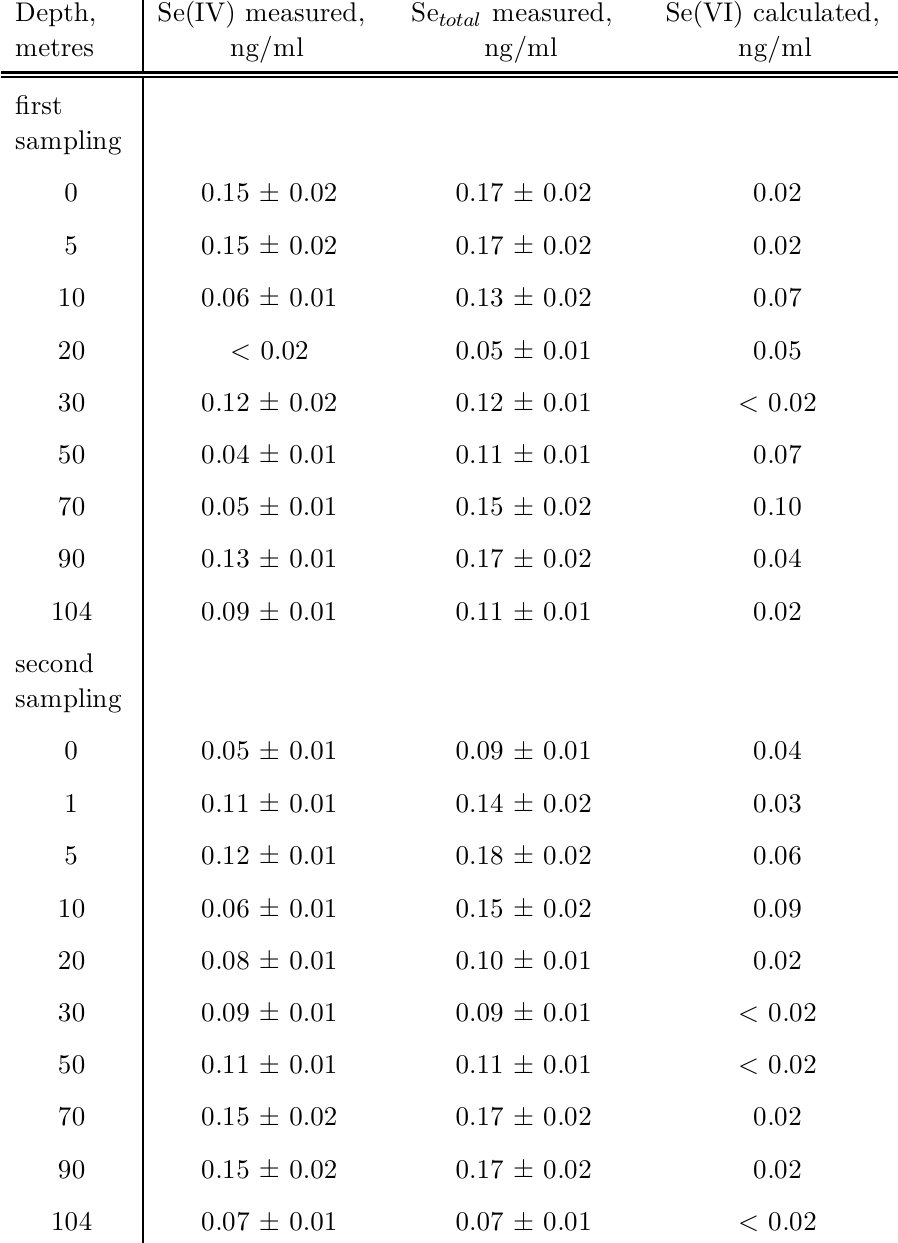
Table 5 Results of the determination of selenium in marine water samples (all measured values are reproducible with relative standard deviations (RSD) below 20